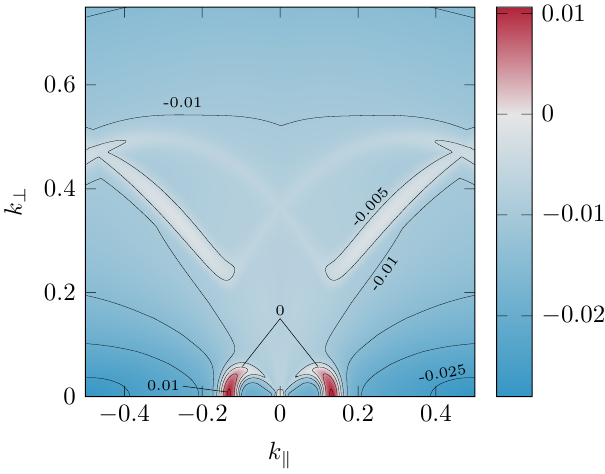
] plotted as a function of k = ( k ) in the first Brillouin Figure 5: Largest Im [ λ (cid:107) , k ⊥ k = 0.02, b = 0, α = 0.03, c = 0.71, δ = 1.76. zone 1 / 2 ≤ k (cid:107) / q < 1 / 2, for ω = 2, b x y ] > 0 are red, indicating an instability, regions where Regions where Im [ λ k ] = 0 are white, indicating a system on the verge of becoming unstable, and Im [ λ k ] < 0, indicating that the Archimedean screw solution is blue regions have Im [ λ k stable there. The largest instability occurs along k ⊥ = 0, at k (cid:107) / q = ±